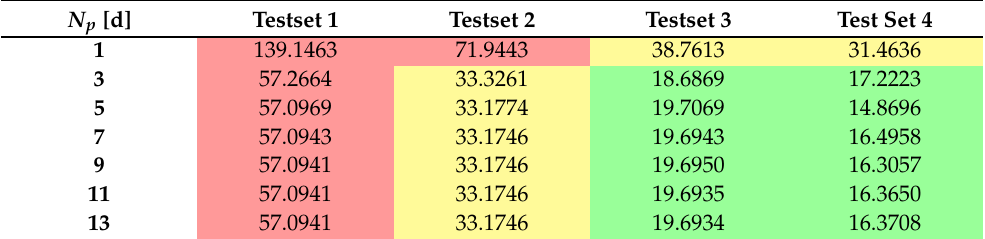
Table 5. Maximum change of water amount discharged from the plant throughout simulations [m 3 ].